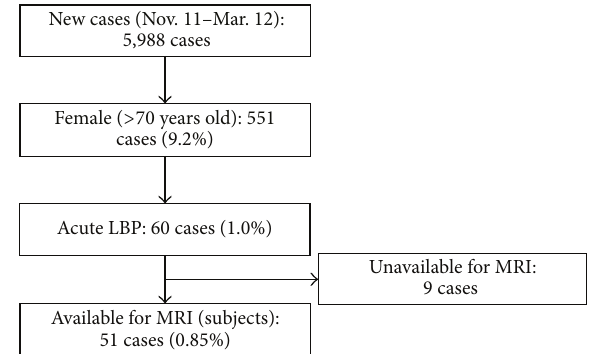
Figure 1: Patient selection flowchart. Among the total of 5,988